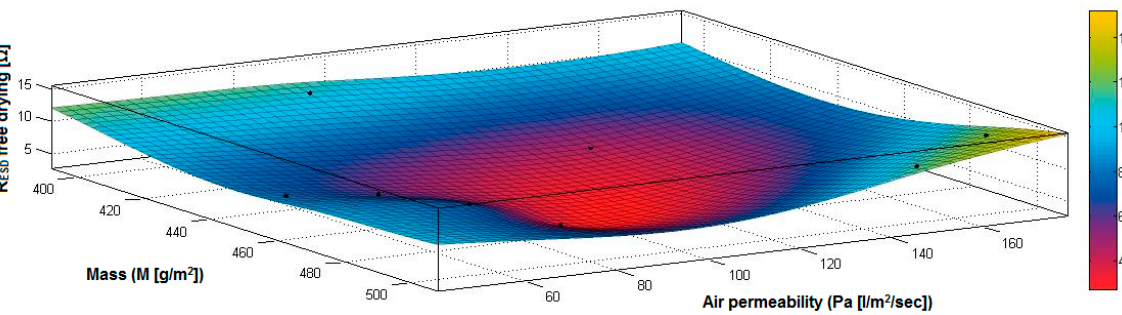
Figure 25. 3D representation R ESD free drying = f(M, Pa) for samples preliminarily treated in RF plasma O 2 using RF 1 generator and power 200 W.